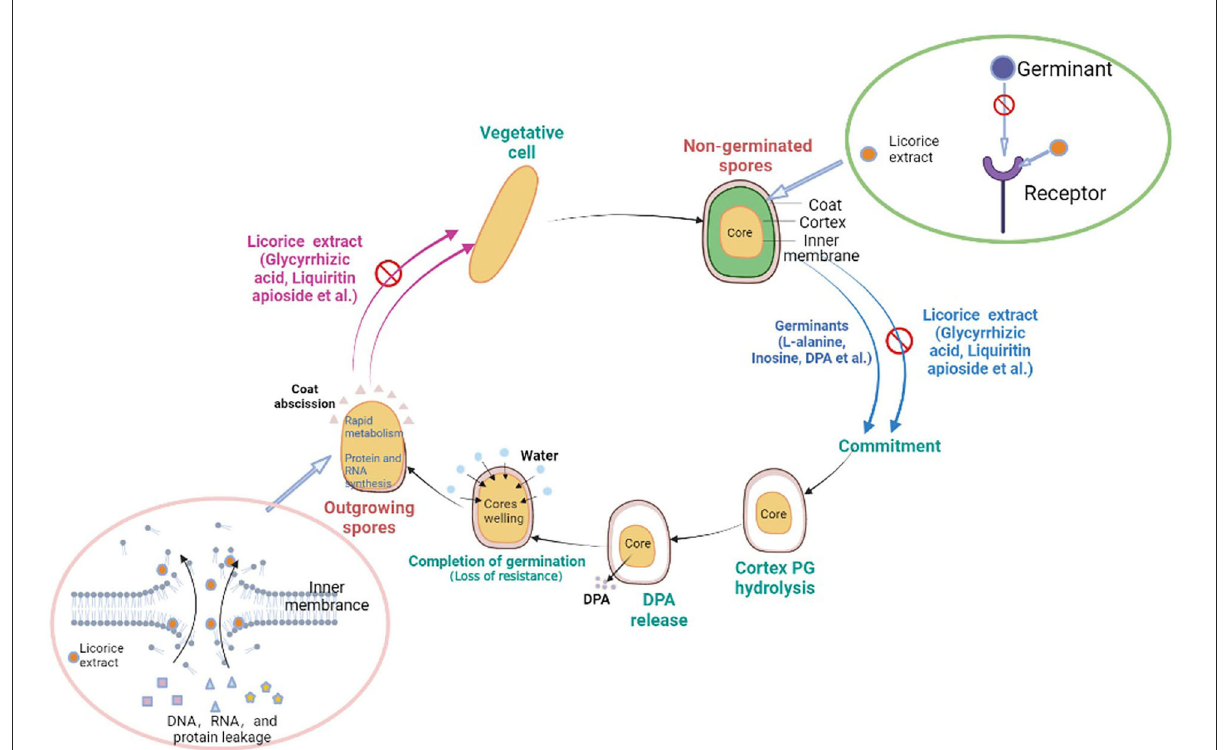
FIGURE6 Schematic model for licorice extract to inhibit the germination and outgrowth of P. bifermentans spores. The non-germinated spores will be triggered by germinants such as L-alanine, inosine, and dipicolinic acid (DPA). On the one hand, prior to germination, the addition of licorice extract (glycyrrhizic acid, liquiritin apioside, etc.) will prevent the binding of germinants to receptors, resulting in the no occurrence of germinant sensing. On the other hand, the outgrowing spores, upon the hydrolysis of the cortex, the release of DPA, and the abscission of the coat, lose their resistance. Treatment with licorice extract at this point will cause damage to the inner membrane of the outgrowing spores and prevent them from becoming vegetative